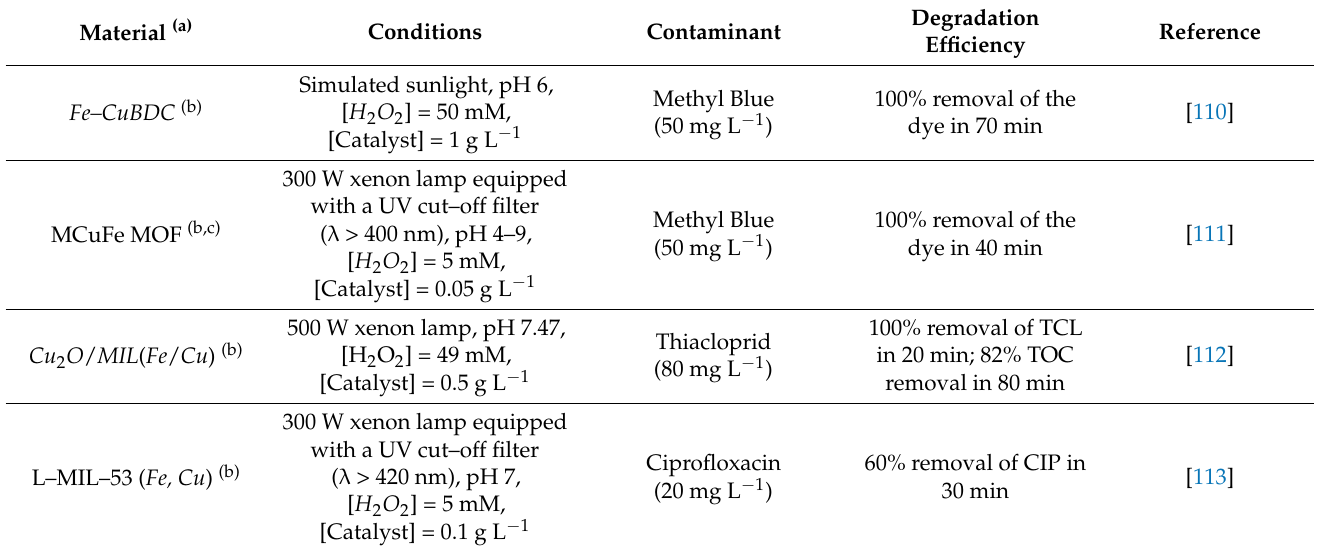
Figure 9. Photo–Fenton reaction mechanism of the charge transfer for hydroxyl radical generation over the MCuFe MOF under visible light irradiation. Reprinted with permission from Ref. [111]. Copyright 2020, Elsevier. Table 4. Summary of recently used Fe–Cu bimetallic MOFs as photo–Fenton photocatalysts in wastewater treatment.